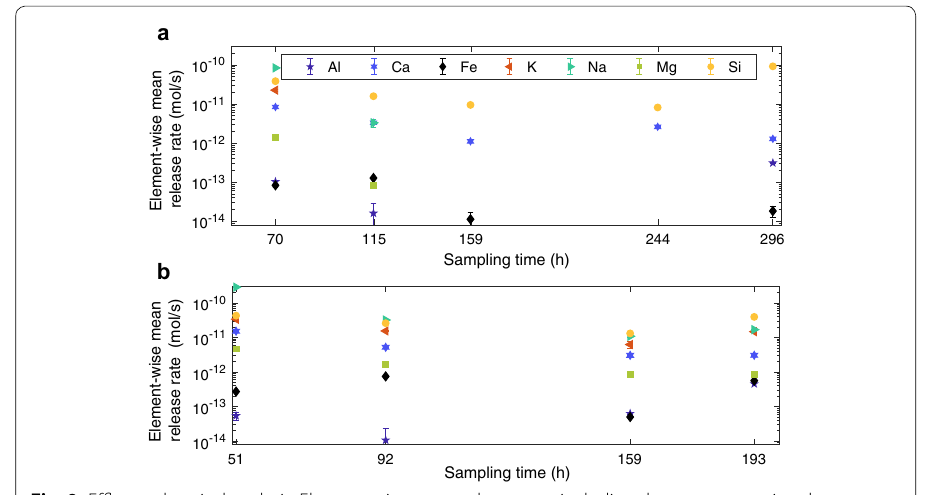
Fig. 9 Effluent chemical analysis. Element‑wise mean release rate, including the ranges associated with equipment error: a first group of experiments: # N14‑S1, # N14‑S2, and # N14‑S3; b second group of experiments: # N19‑C1 and # N19‑C2